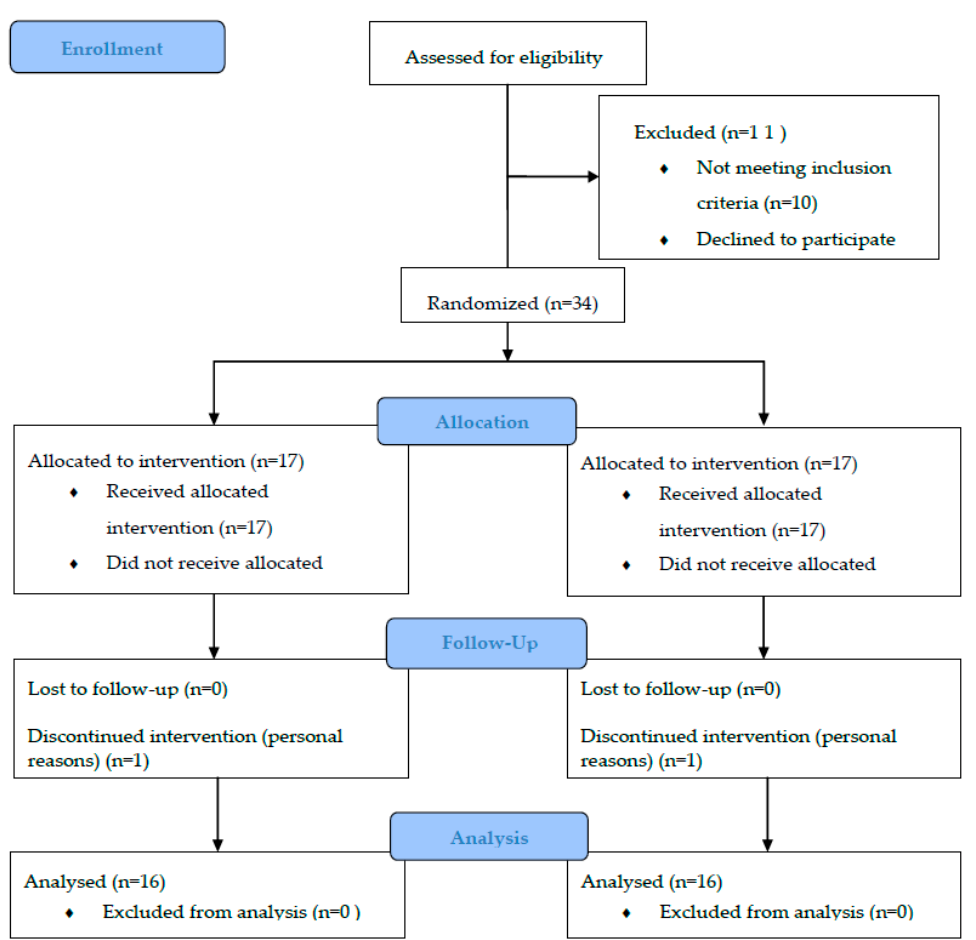
Figure 1. CONSORT flow diagram. This figure shows the flow of participants through the trial according to the criteria recommended in the CONSORT guidelines.; EX = Voluntary exercise group; EX + WB-EMS = Voluntary exercise with whole-body electromyostiulation (WB-EMS).